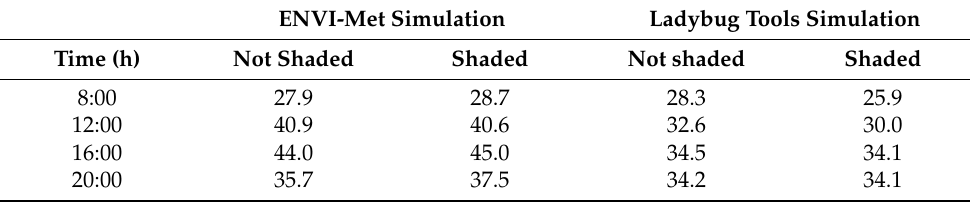
Time (h) Not Shaded Shaded Not